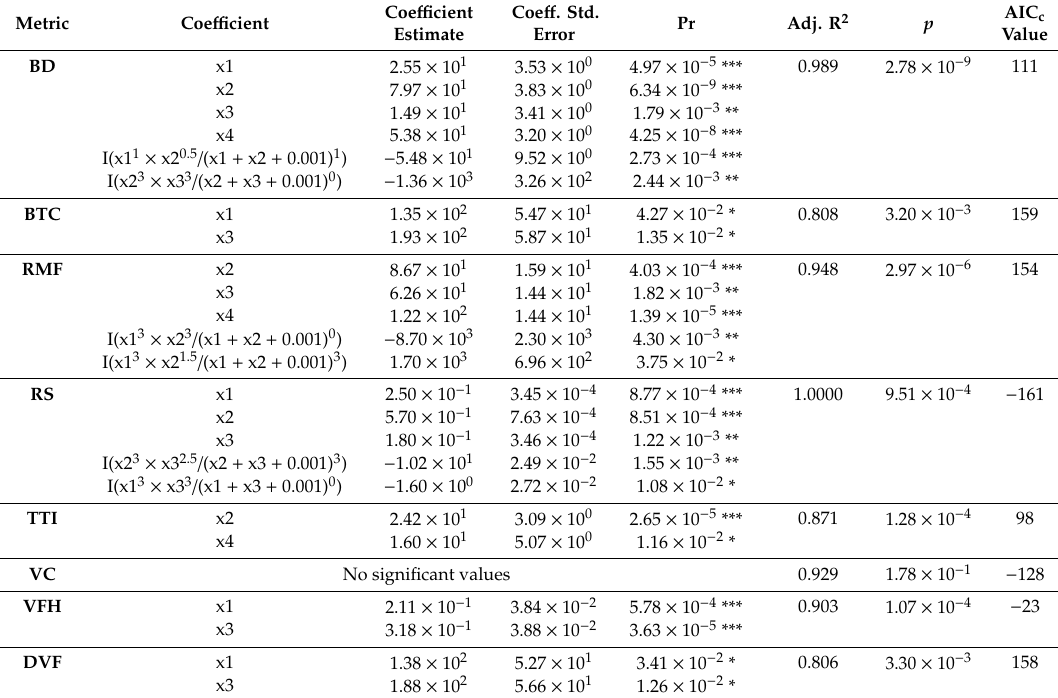
Table 6. Model outputs for Halls Creek for bulk density (BD), burn to completion (BTC), residual mass fraction (RMF), rate of spread (RS), time-to-ignition (TTI), volume consumed (VC), vertical flame height (VFH) and duration of visual flaming (DVF). x1 is other, x2 is twigs, x3 is leaves, x4 is decomposed material, statistical significance codes: 0 “***”, 0.001 “**”, 0.01 “*”, AIC c is the Akaike information criterion for small sample sizes.